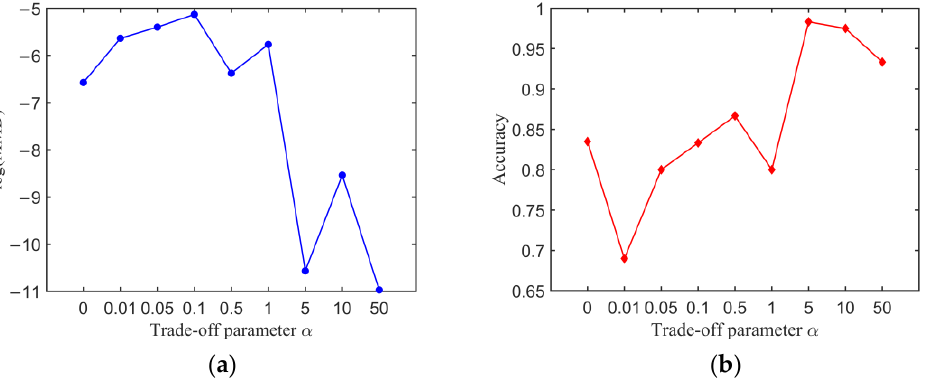
Figure 11. Transfer results of MMD-DANN model with different trade-off parameter α : ( a ) MMD of the extracted features and ( b ) classification accuracy.